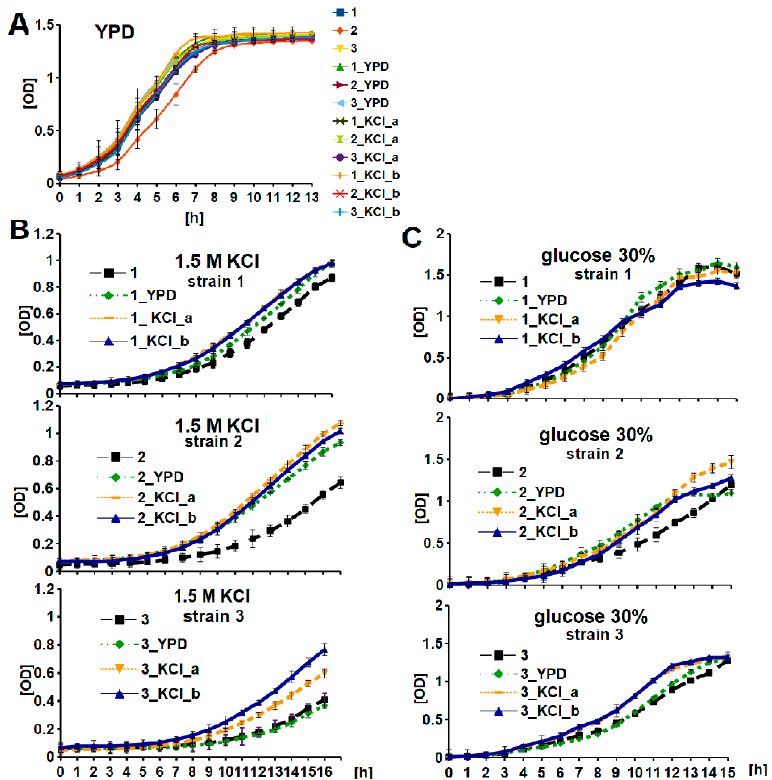
Figure 1. Generational and osmotic stress-induced changes in the growth rate of strains 1, 2, and 3. Ancestral and evolved yeast strains were grown in ( A ) YPD medium under standard conditions; ( B ) in the presence of 1.5 M KCl; or ( C ) high glucose concentration. Data are presented as the means ± SD; n = 3. 1, 2, and 3–ancestral strains 1, 2, and 3, respectively; 1_YPD, 2_YPD, 3_YPD–YPD-evolved derivatives of strains 1, 2, and 3 (control), respectively; 1_KCl_a, 2_KCl_a, and 3_KCl_a–1.25 M KCl-evolved derivatives of strains 1, 2, and 3, respectively; 1_KCl_b, 2_KCl_b, and 3_KCl_b–1.5 M KCl-evolved derivatives of strains 1, 2, and 3, respectively.